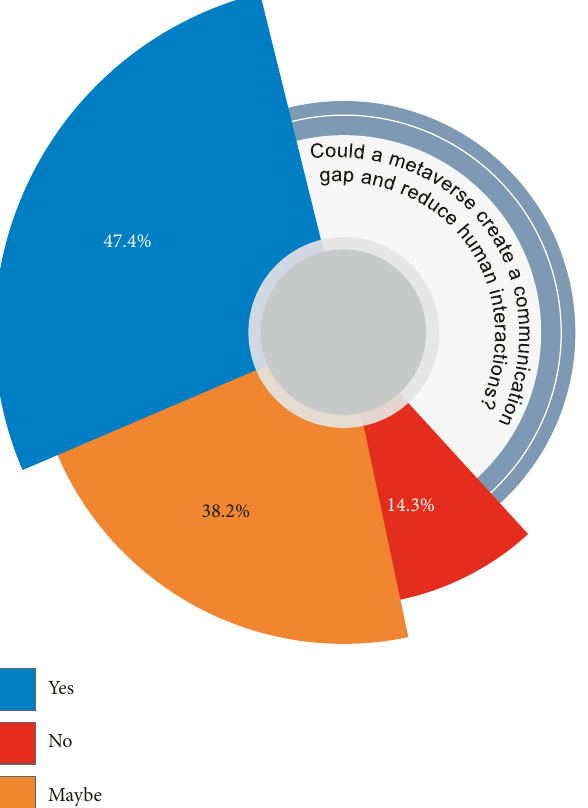
Figure 12: Summarization of the responses when people were asked if a metaverse would reduce physical activity in